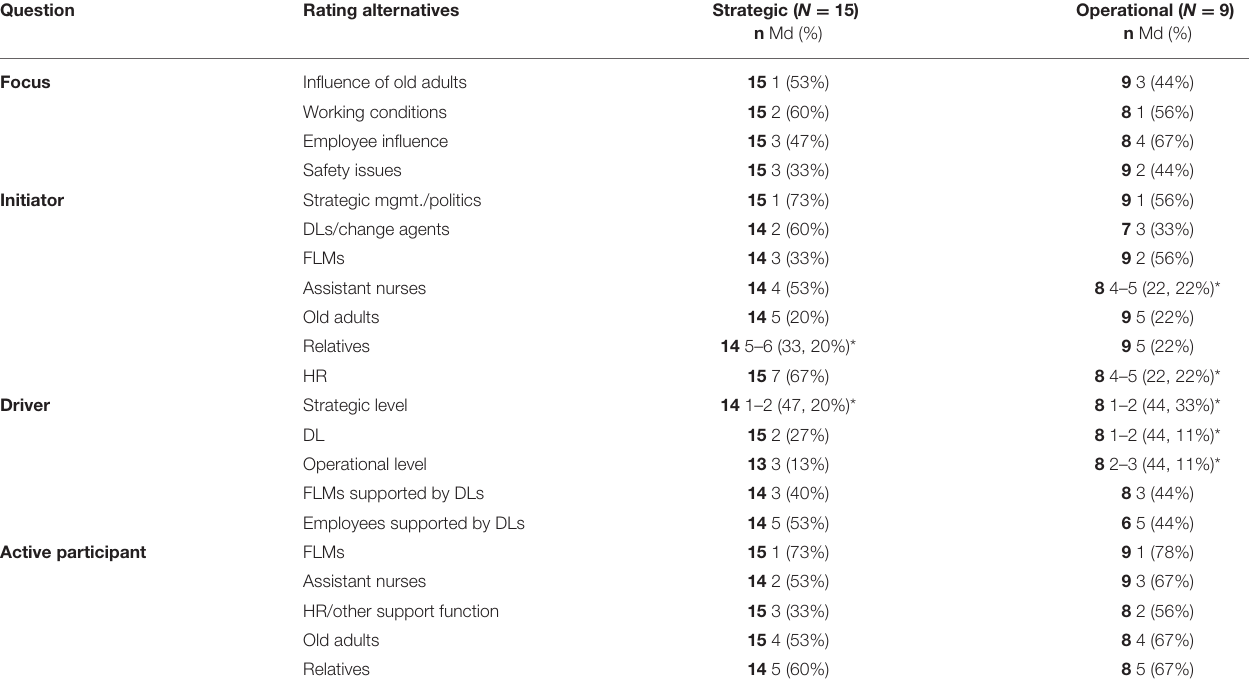
TABLE 2 | Focus, initiative, driver, and contribution for development projects in eldercare, rated by developments leaders.